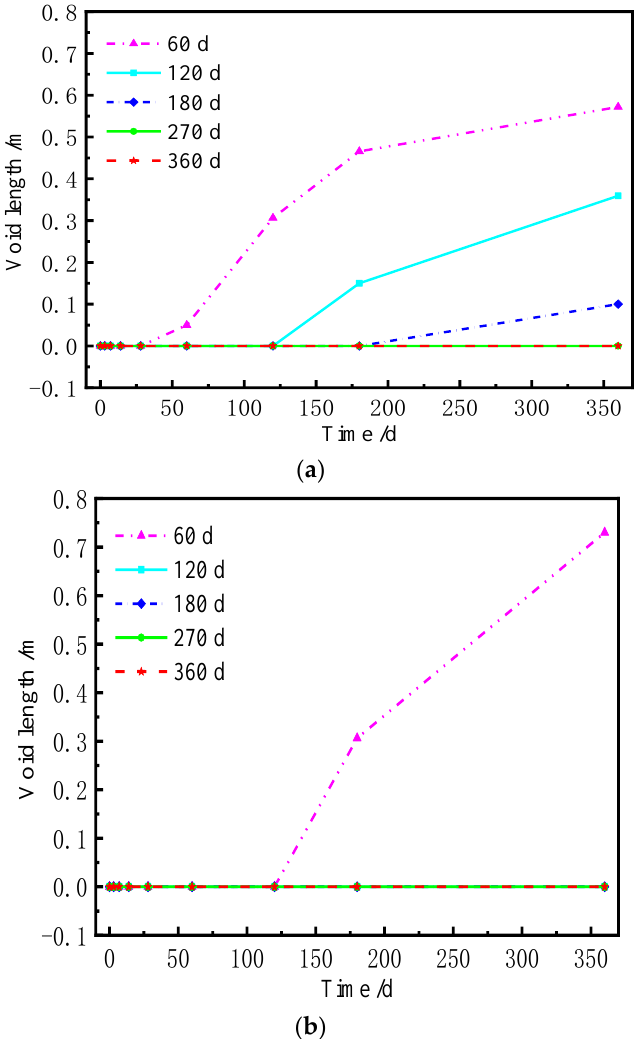
Figure 19. Gap length of the sliding layer at the slab edge. ( a ) With the shear cogging. ( b ) Without the shear cogging.